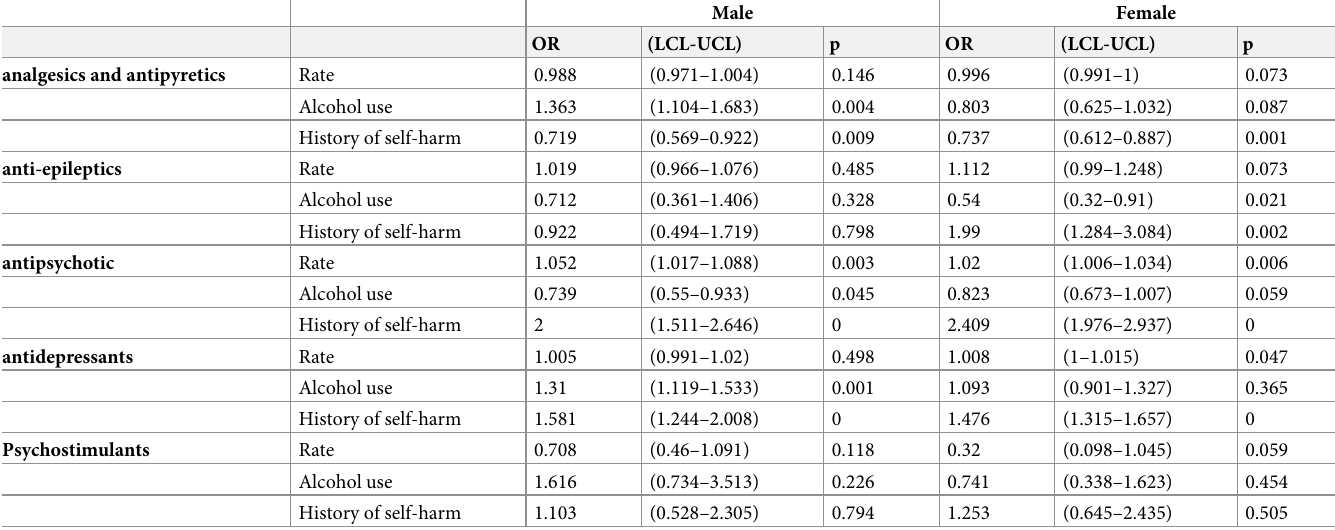
Table 3. Odds ratio due to specific drug categories, prescription rates, alcohol use and history of self-harm per